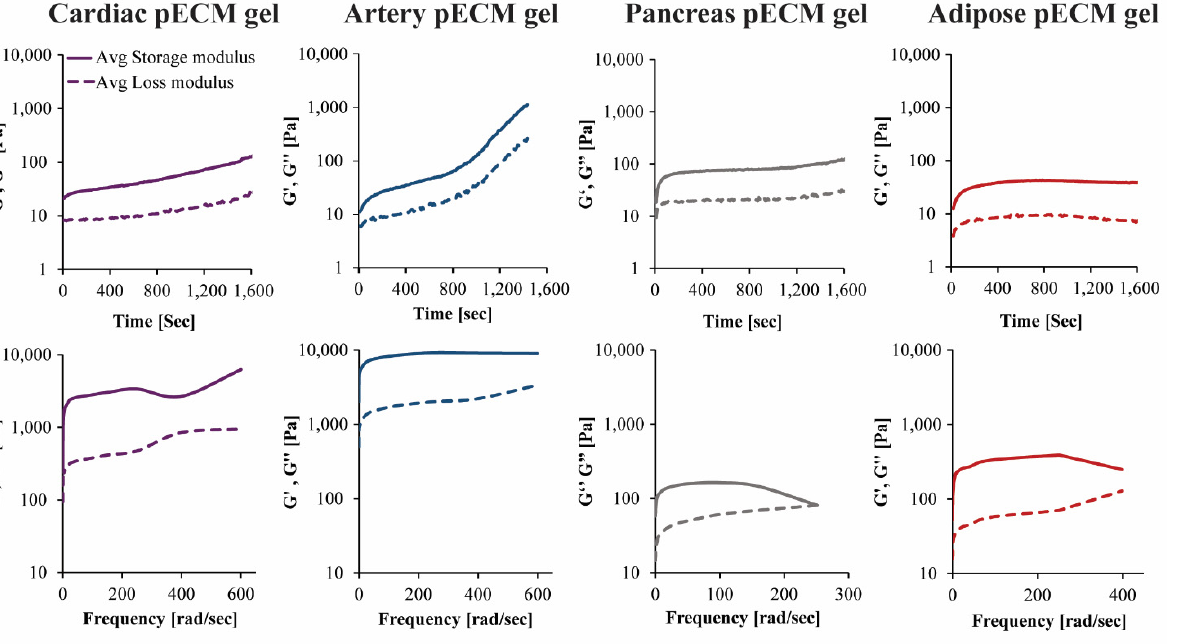
Figure 4. Mechanical properties of the pECM hydrogels. Upper panel: Time sweep rheological characterization, changes in storage (G’) and loss (G”) moduli over time. Lower panel: Frequency sweep rheological characterization, changes in storage (G’) and loss (G”) moduli in ascending frequencies.